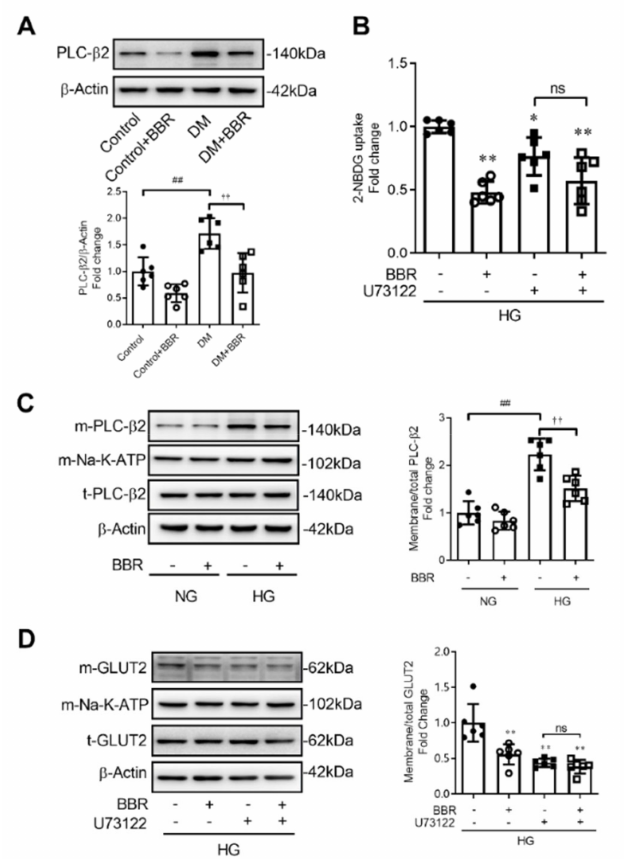
Figure 4. Berberine decreased GLUT2 translocation and glucose uptake through inhibiting the PLC- β 2-GLUT2 signal pathway. ( A ) Berberine treatment (200 mg · kg − 1 · day − 1 , BW) for 6 weeks decreased intestinal PLC- β 2 expression in the DM + BBR group compared to mice in the DM group. ( B ) U73122 (10 µ M), one of the PLC- β 2 inhibitors, blocked berberine’s effects on glucose uptake in IEC-6 cells. ( C ) Berberine decreased membrane localized PLC- β 2 in IEC-6 cells. ( D ) U73122 (10 µ M), one of the PLC- β 2 inhibitors, blocked berberine’s effects on GLUT2 translocation. Data are expressed as mean ± SEM ( n = 6). m-Na-K-ATP was used as internal reference of the membrane protein. HG, high concentration of glucose (50 mM); m-GLUT2, membrane localized GLUT2; t-GLUT2, total GLUT2; m-PLC- β 2, membrane localized PLC- β 2; t-PLC- β 2, total PLC- β 2; U73122, PLC- β 2 inhibitor. * p < 0.05, ** p < 0.01, vs. control; ## p < 0.01, †† p < 0.01; ns, no